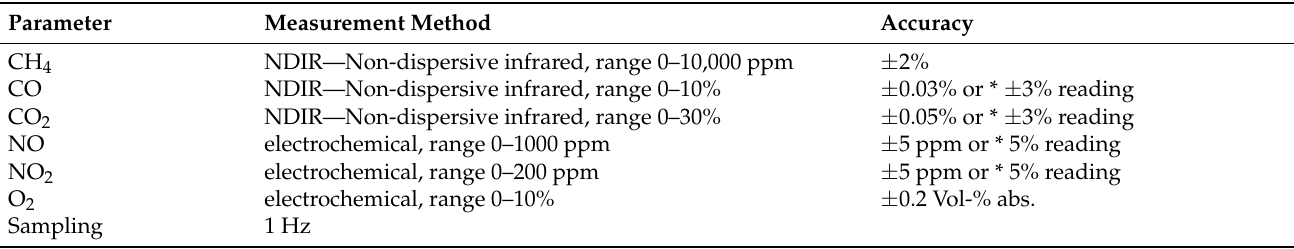
Table 3. Technical characteristics of VARIOplus